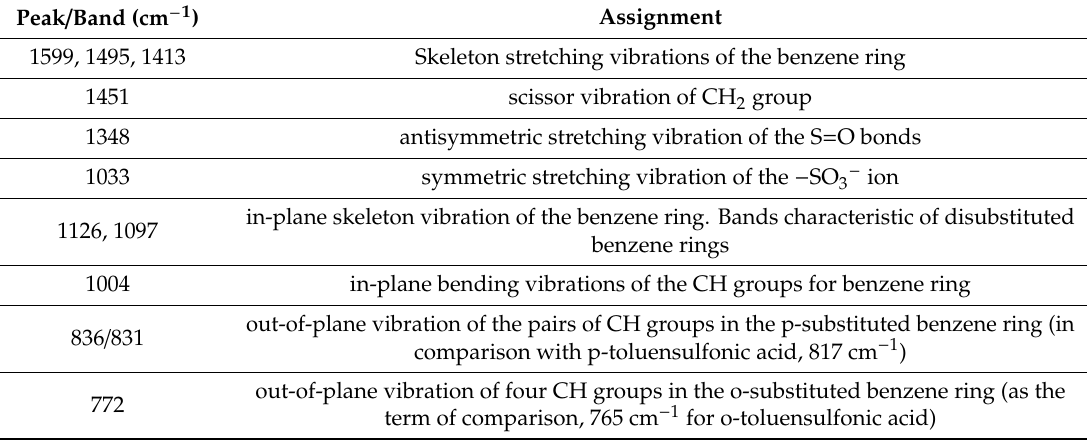
Table 3. Diagnostic signals of sulfonic poly(styrene-divinylbenzene) materials, with the pertinent